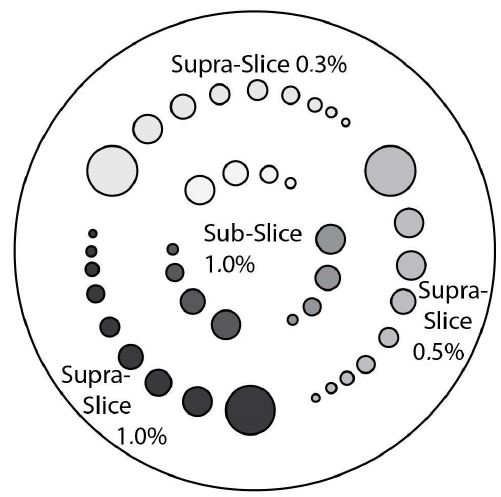
Figure 10. Section of the CTP515 low contrast module.